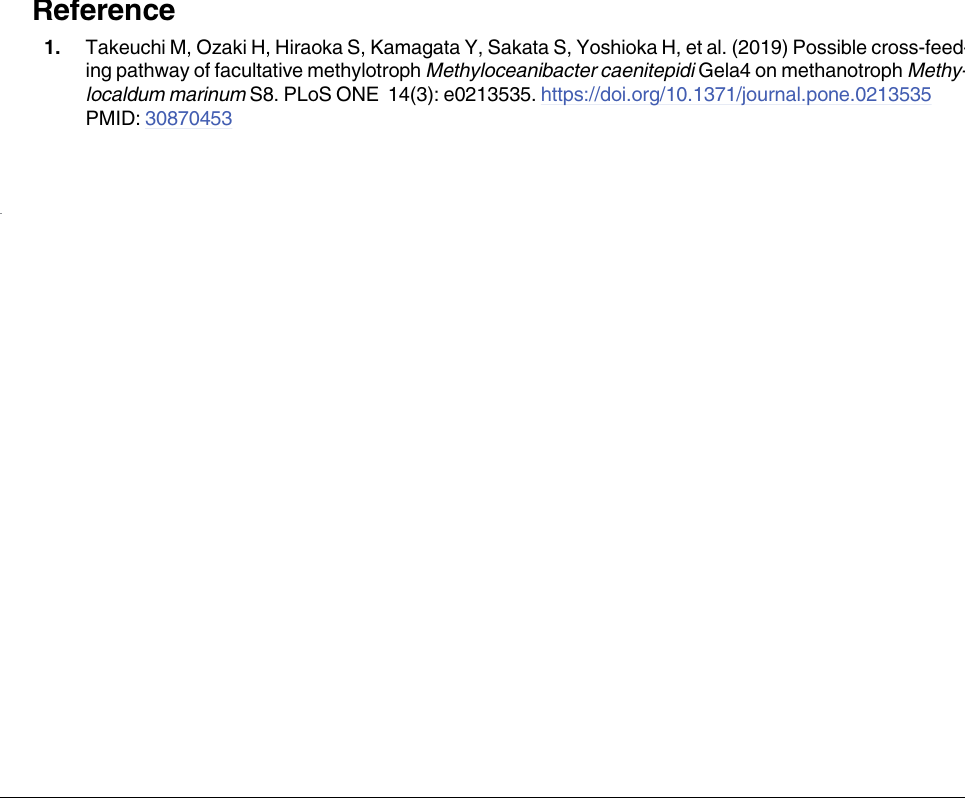
S6 Table. Transcriptomics data of M. marinum S8 grown in co-culture with M. caenitepidi Gela4 and methane. S8 Table. Expression profiles of major genes in the central metabolism of M. marinum S8 grown with M. caenitepidi